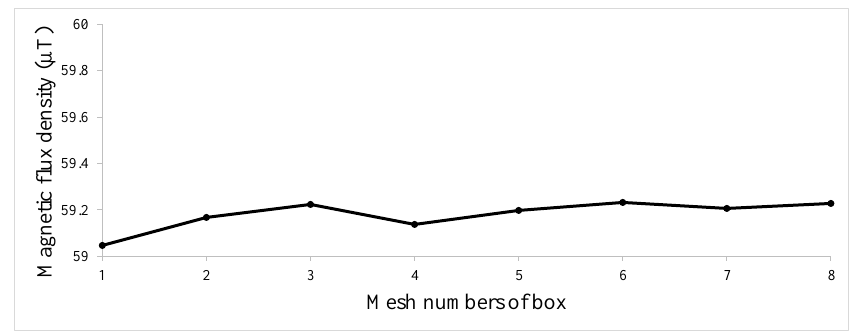
Figure 13. Minimum values of Z-component magnetic flux density, from 295.0592 mm to 307.0592 mm (values related to Hole 2), for different box mesh specifications with a fixed rebar mesh #8 (Table 4).